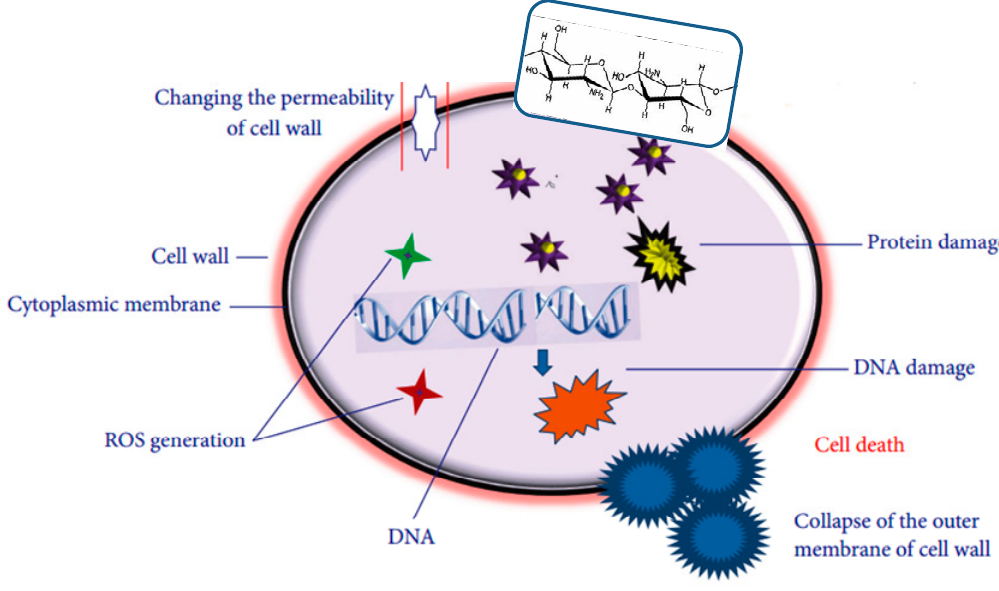
Figure 1. Principal mechanisms of antimicrobial action of chitosan. Adapted from [11], copyright © 2020, Xing et al.